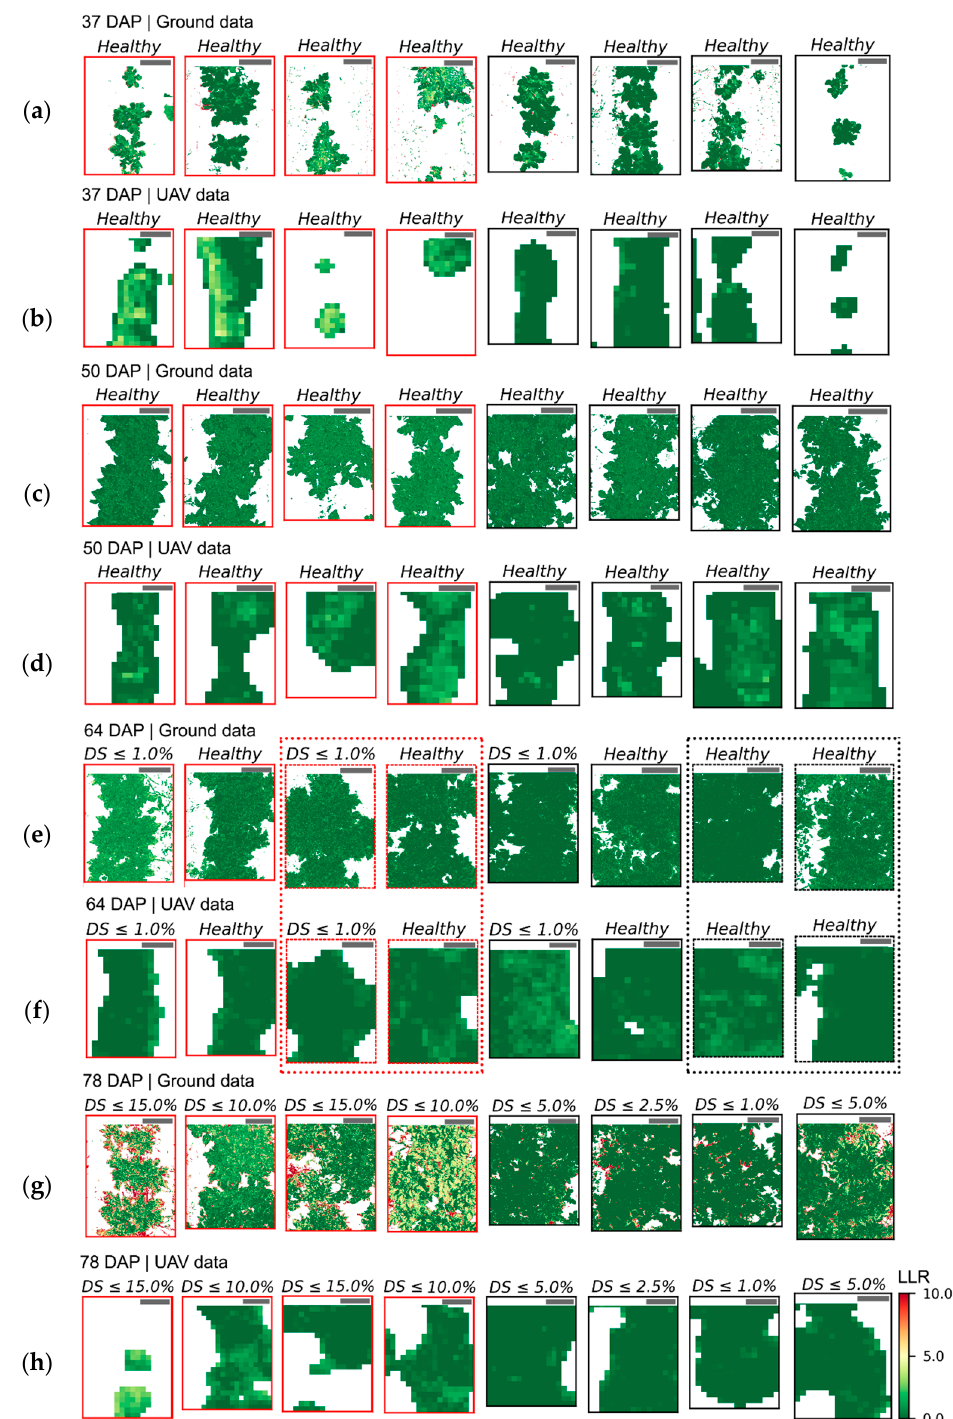
Figure A6. Log-likelihood ratio (LLR) for ground-based ( a , c , e , g ) and UAV imagery ( b , d , f , h ). LLR, in this case, indicates the comparison of pixel-wise probability estimated for T1 (H1; “non-mixed” system) in contrast to T2 (H0; “mixed” system). SUs cultivated with T1 are represented with red frames and scale bars in the left upper corner of each image correspond to 25 cm. For 64 DAP, frames represented in dashed lines indicate SUs not measured during other acquisitions and which cannot be compared over time.